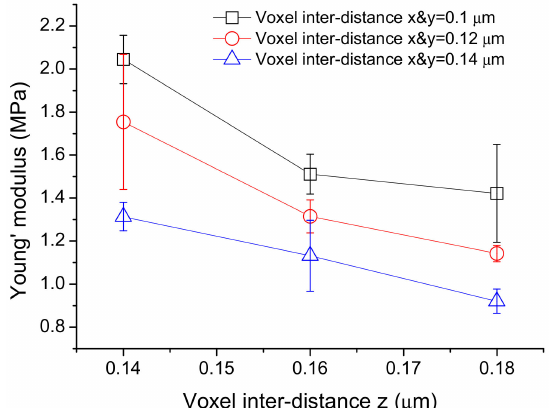
Figure 9. Variation of Young’s modulus with inter-voxel distances: Young’s modulus from cantilever bars with the same nominal dimensions that were fabricated with an average laser power of 0.15 mW but with different inter-voxel distances. Each data point is averaged from three specimens and the error bars indicate the standard deviation of data. In all cases, the average Young’s modulus increases with a decreasing inter-voxel